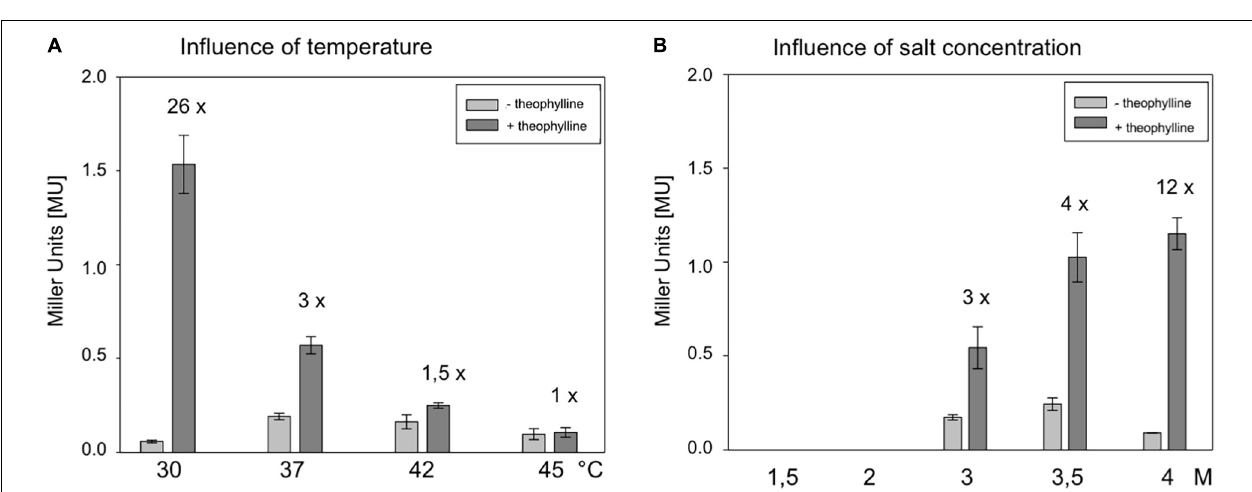
FIGURE 4 | Characterization of the theophylline-dependent riboswitch E in respect to cultivation temperature and salt concentration of the medium. (A) Effect of temperature on the activation of riboswitch E in Hfx. volcanii . RE transformants were incubated for 48 h at 30, 37, 42, or 45 ◦ C in 3 M salt media in the presence or absence of 2 mM theophylline, and the BgaH activity was determined. (B) Effect of the salt concentration on the activation of riboswitch E in Hfx. volcanii transformants. RE transformants were cultured at 37 ◦ C for 37 h in media containing 1.5, 2, 3, 3.5, or 4 M NaCl in the presence or absence of 2 mM theophylline, and the BgaH activity was determined ( Supplementary Table 4 ). All experiments were performed in triplicates on three different days.